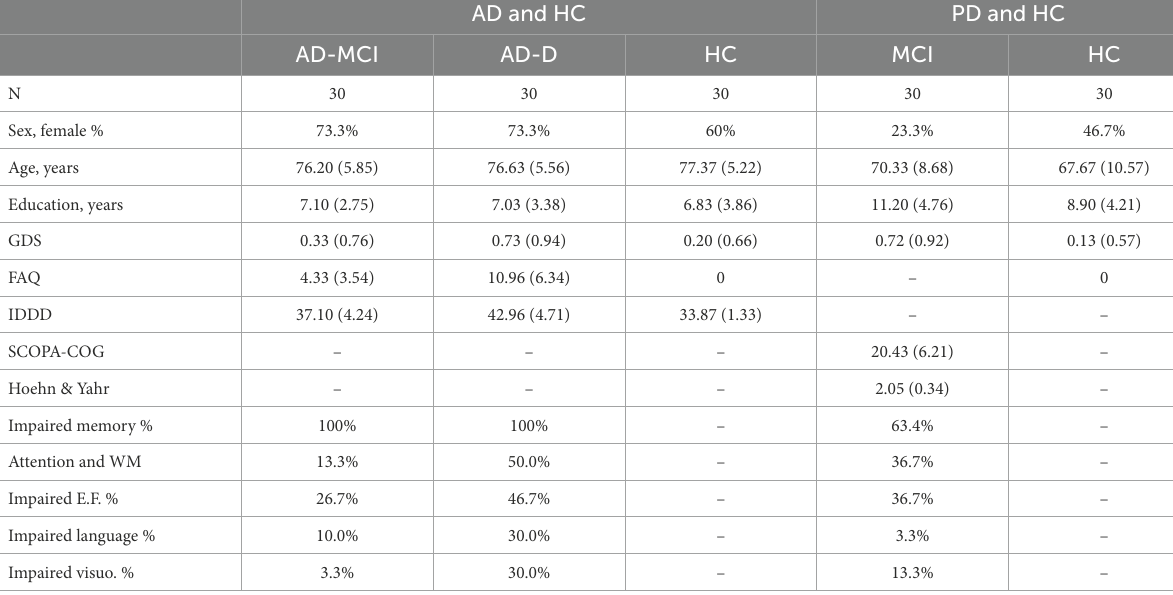
TABLE 1 Main demographic and clinical characteristics of all